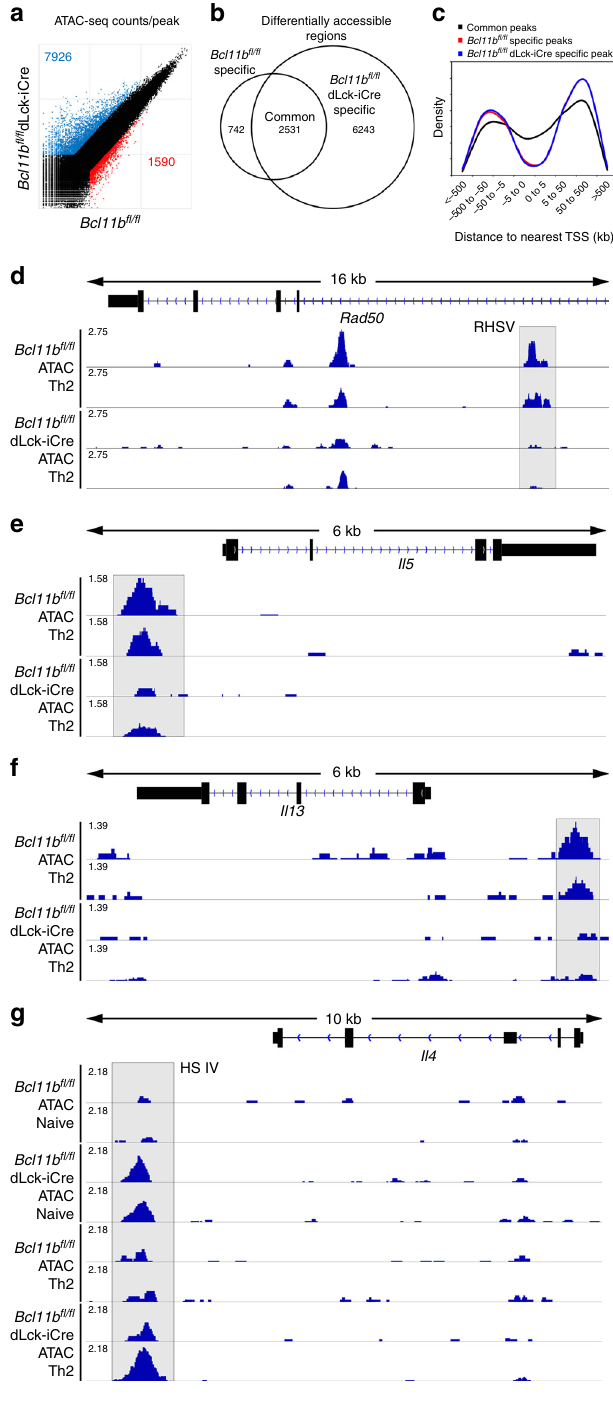
Fig. 6 Removal of Bcl11b results in reduced chromatin accessibility at key Th2 loci and increased accessibility at the Il4 HS IV silencer. a Scatterplot of normalized ATAC-Seq coverage per peak. b Venn diagram of the distribution of signi fi cantly differentially accessible regions. Signi fi cance was calculated by MAnorm analysis and was de fi ned as |log2(fold- change)| > 1 and p < 0.05. p value was adjusted for the FDR (false discovery rate) by the Benjamini – Hochberg adjustment. c Density distribution of accessible regions relative to the nearest transcription start site (TSS). Data obtained from Genomic Regions Enrichment of Annotations Tool (GREAT). Rad50 Th2 LCR (RHS V highlighted) ( d ), Il5 (promoter highlighted) ( e ), Il13 (promoter highlighted) ( f ), and Il4 ( Il4 HS IV silencer highlighted) ( g